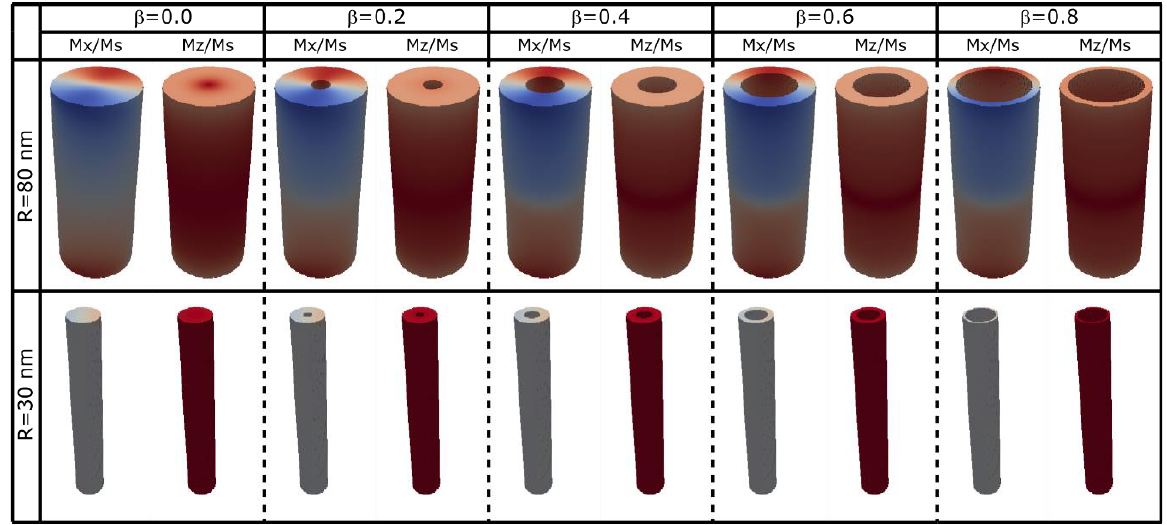
Figure A3. Magnetization reversal of a 1000 nm long Fe 3 O 4 nanotube with an external radius of 80 nm, for β = 0.0 ( a ), 0.1 ( b ), and 0.2 ( c ). The graphs on the left depict the components of magnetization as a function of time, while the snapshots of magnetization at specific times are presented on the right of each graph.